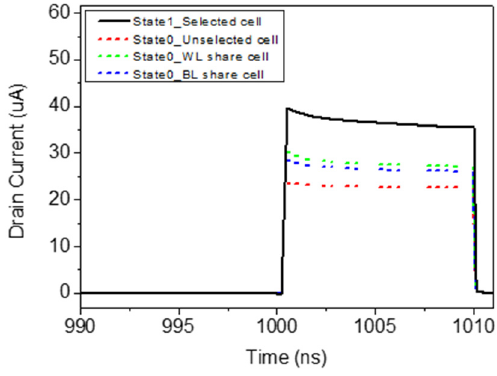
Figure 6. Read current for “0”-“1” case (example of disturbance).